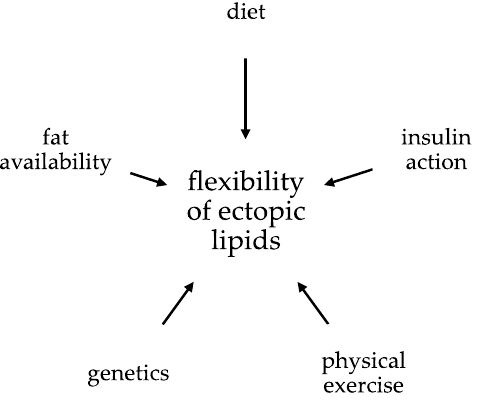
Figure 4. Factors influencing lipids: See text for details.